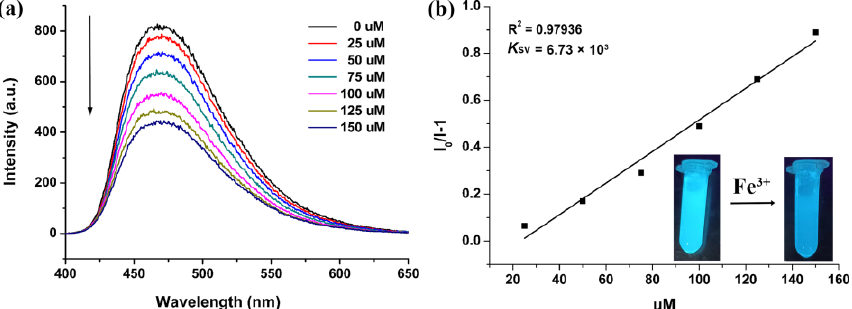
Figure 4. ( a ) FL of Sr 2 (tcbpe) with the addition of 0.5 × 10 −2 M Fe 3+ ions in an increasing amount. ( b ) The corresponding K sv curve. Insets show the FL photographs of Sr 2 (tcbpe) before and after the addition of Fe 3+ ions.